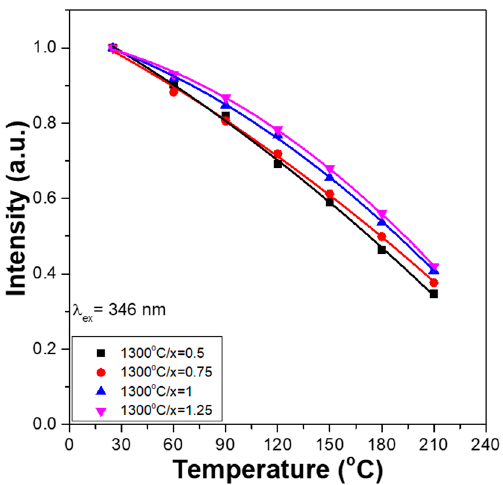
Figure 7. Temperature dependence PLEmax values of Ca x Mg 2-x Si 2 O 6 :0.025Eu 2+ phosphors. The decay time of all Ca x Mg 2-x Si 2 O 6 :0.025Eu 2+ phosphors is defined as when the in-